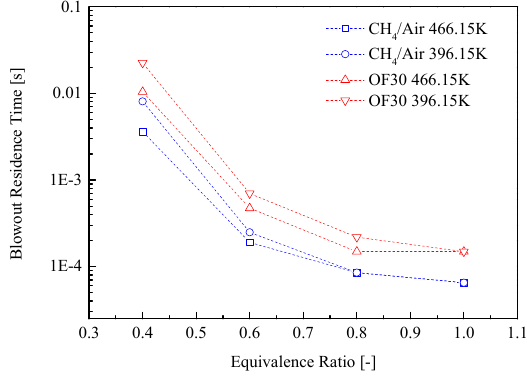
Figure 10. Dependence of blowout residence time on equivalence ratio.